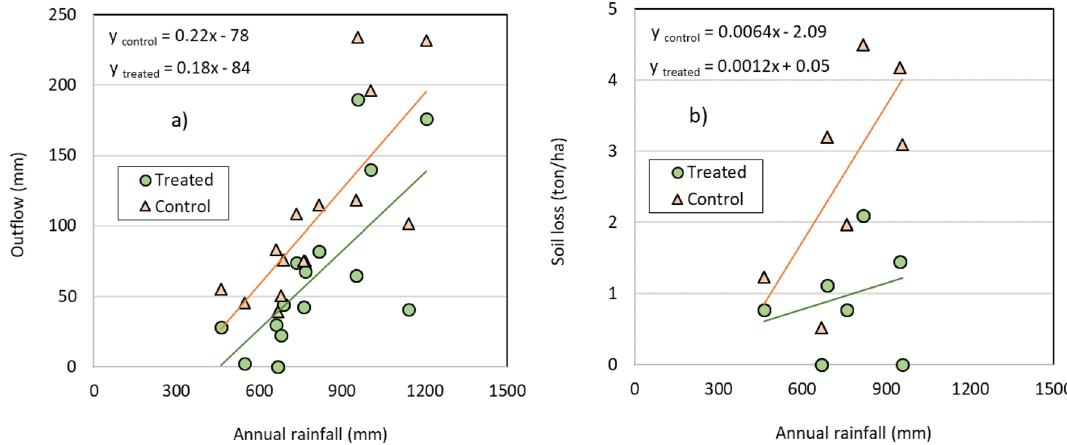
Figure 11. Reduction in ( a ) outflow and ( b ) soil loss measured following rainwater harvesting interventions in different rainfall zones.